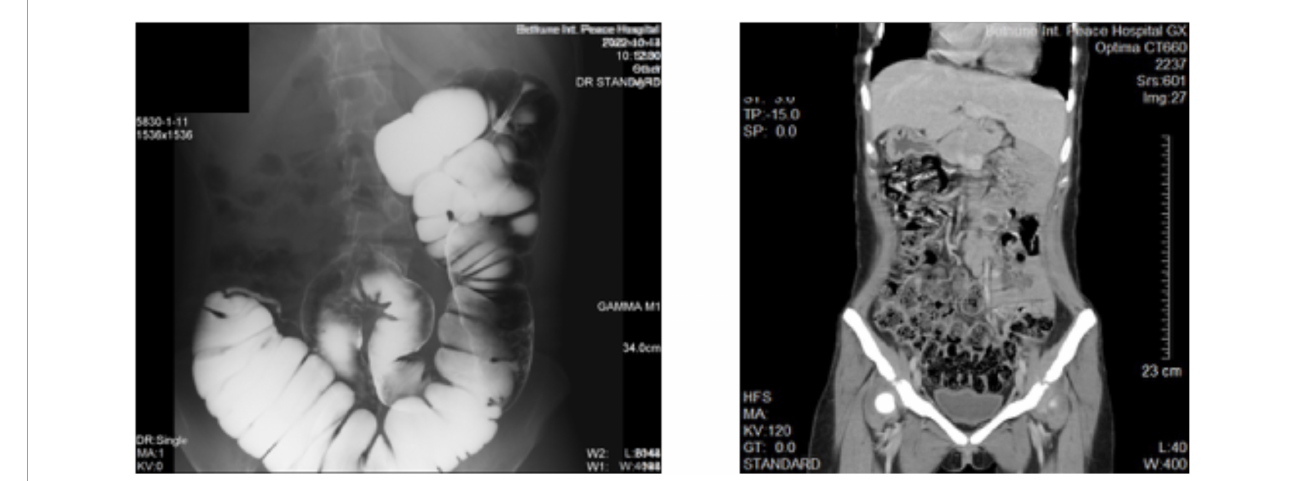
FIGURE1 Imaging images of the patient’s abdomen. (Left) Barium examination. (Right) Full abdominal CT scan.